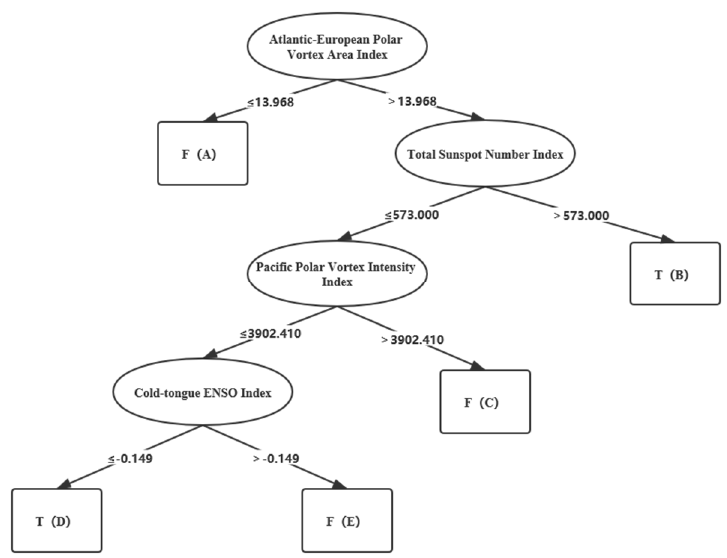
Figure 8. The classification tree model derived for cluster 2 of the Poyang Lake basin.